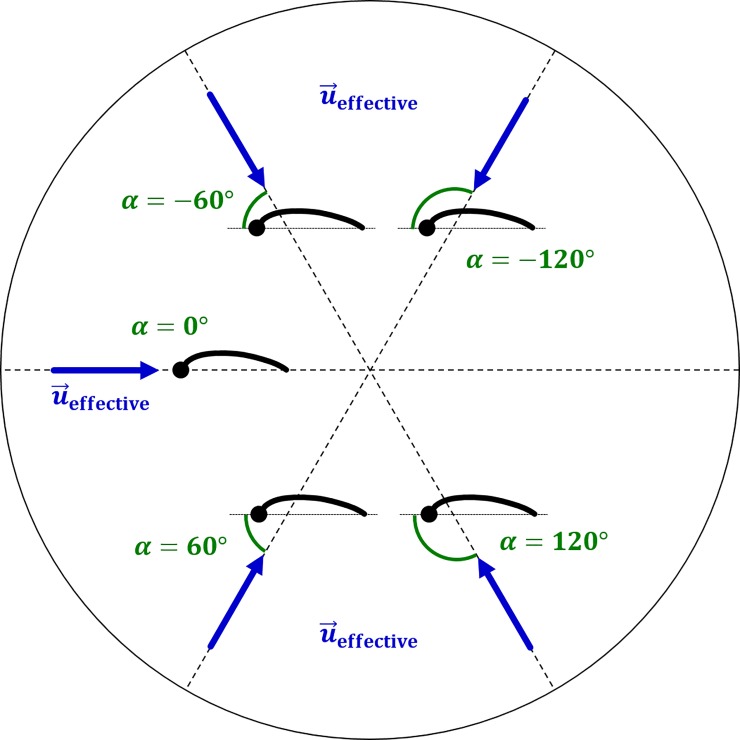
Interpretation of αeffective (or α).